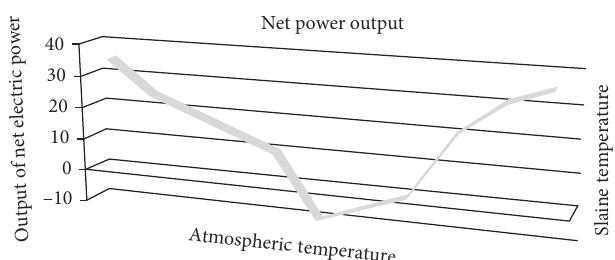
Figure 6: Net power output.